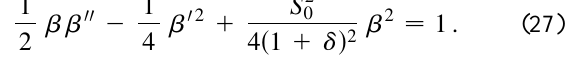
p E k maximum (solid